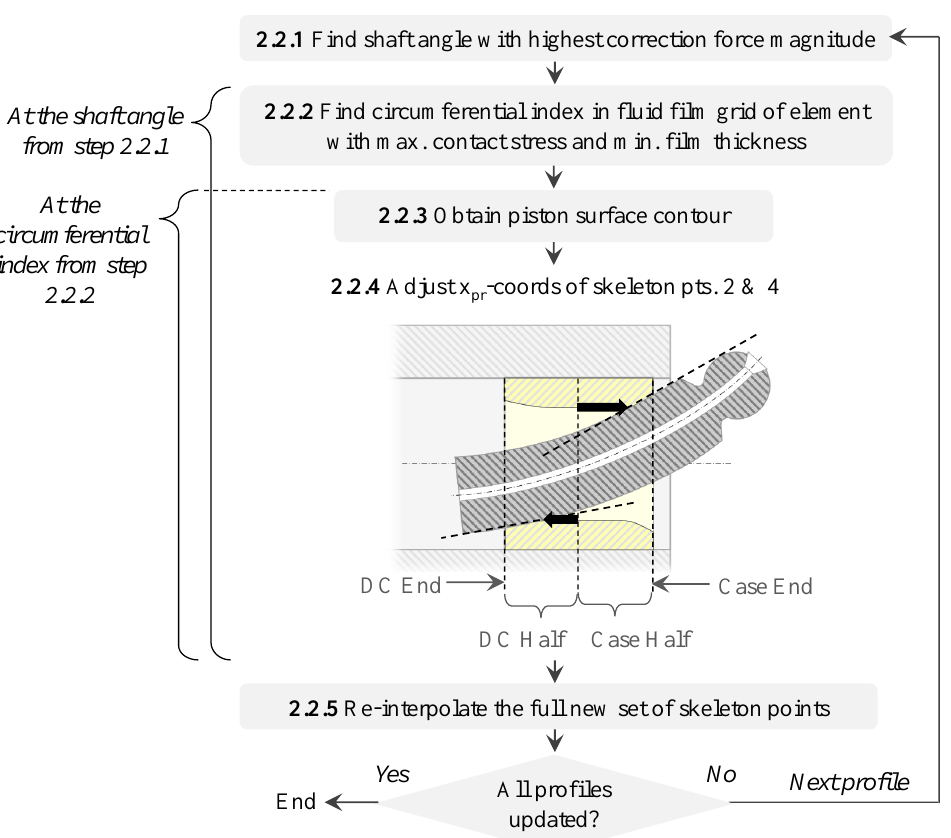
Figure 16. Adjusting the x pr -coordinates of skeleton points 2 and